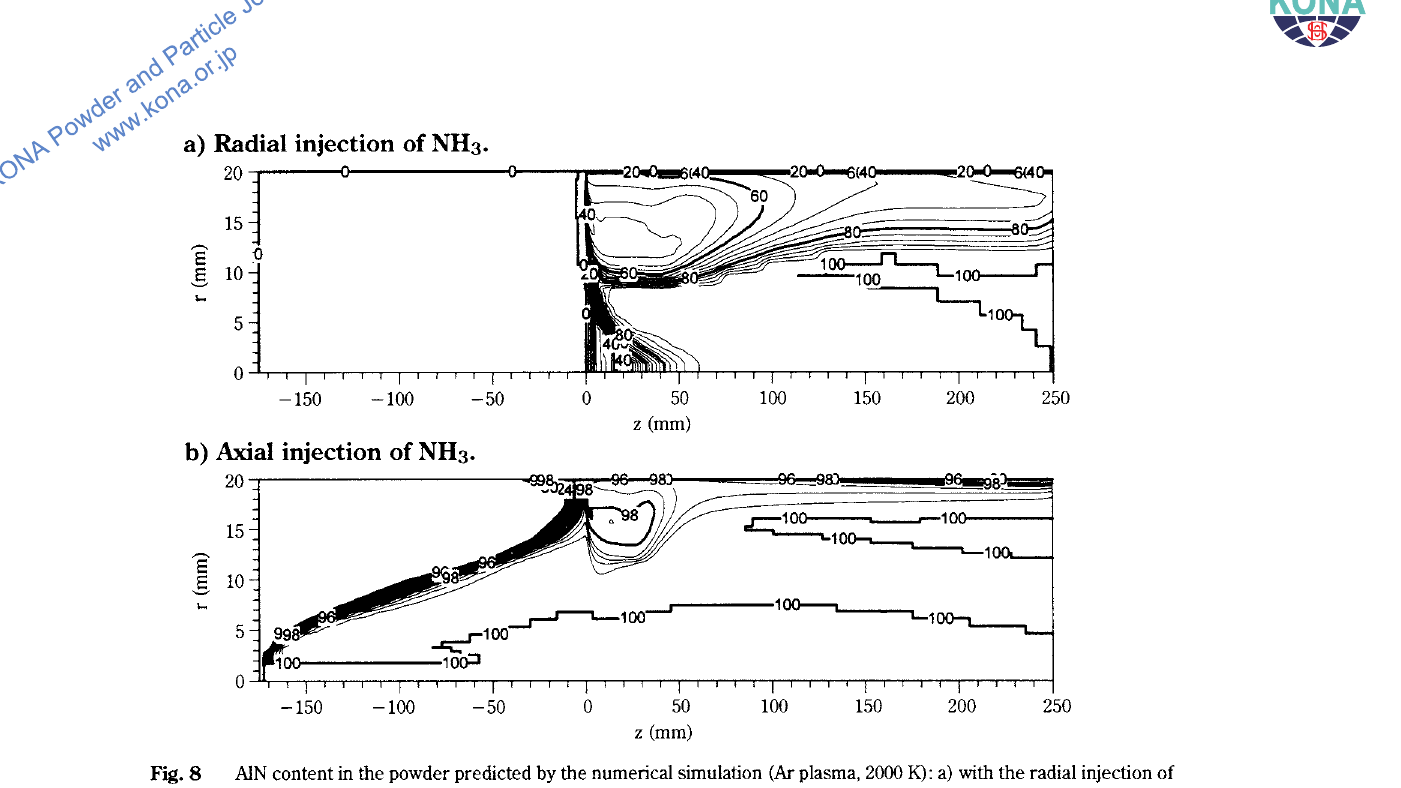
AIN content in the powder predicted by the numerical simulation (Ar plasma, 2000 K): a) with the radial injection of NH 3 (2lpm); and b) with the axial injection of NH 3 at z= -175 mm, and radial injection of N 2 (6lpm) at z=O mm. larger sizes and broader size distribution observed in Figure 9 (b) are typical of longer residense times in a hot reaction zone. In contrast, the TEM micrograph